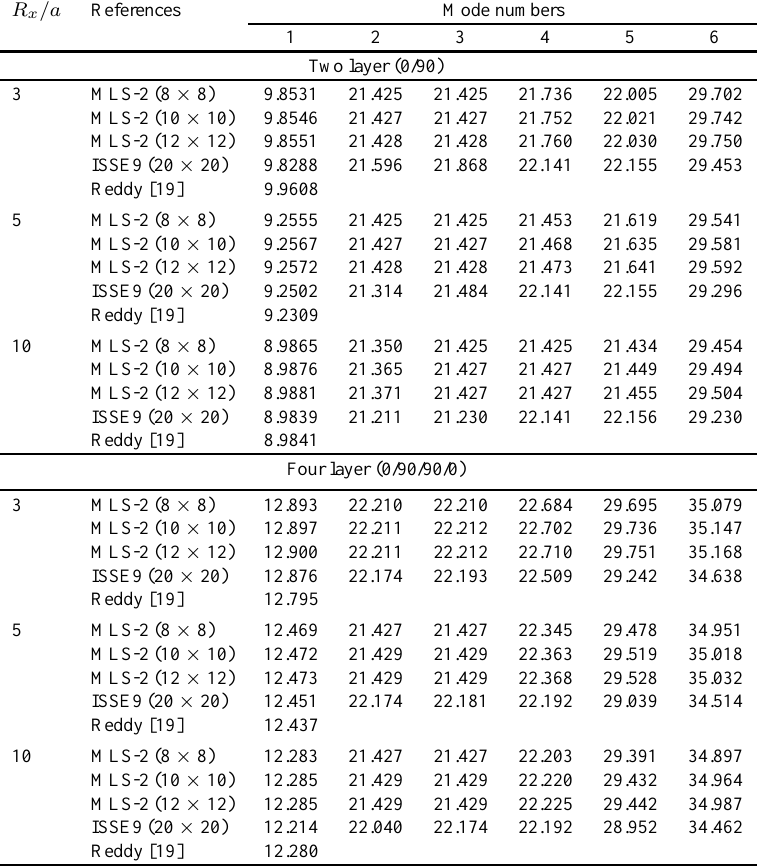
(cid:1) Table 3 ρ/E 2 h 2 ) of a cross-ply spherical shell panel (Fig. 2)